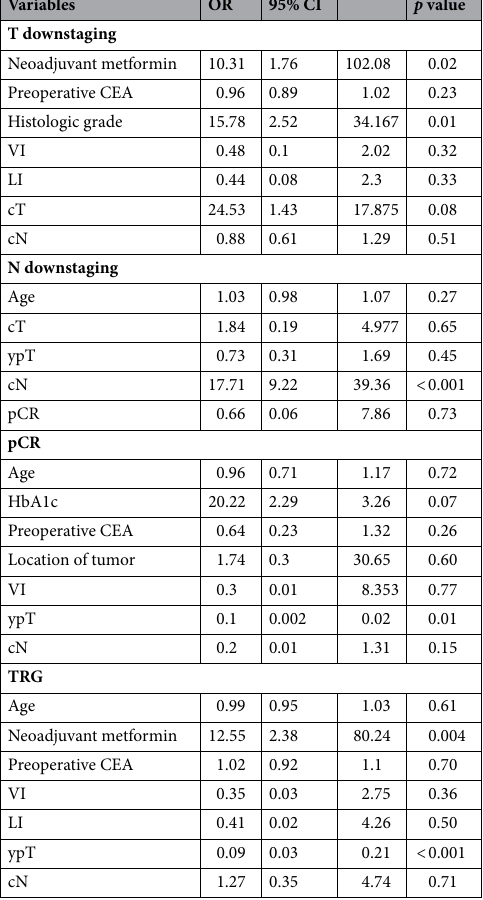
Table 3. Multivariable logistic regression analysis for tumor response. VI = vascular invasion, LI = lymphatic invasion, CEA = carcinoembrionic antigen, TRG = tumor regression grade, CI = confidence